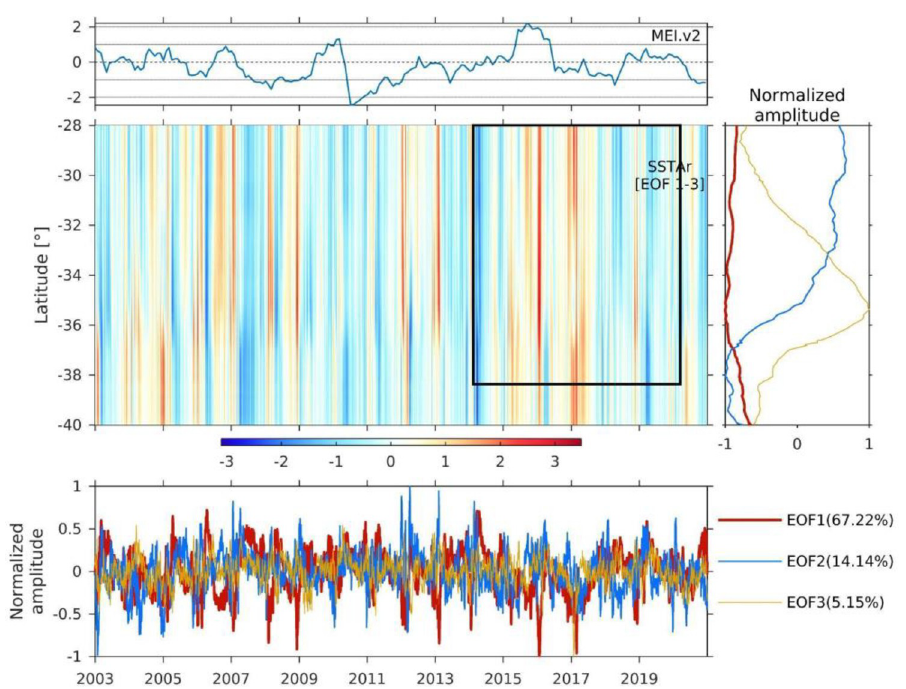
Fig 8. Time series of multivariate ENSO index version 2 (https://psl.noaa.gov/enso/mei/) (MEI, upper panel), and Hovmo¨ller diagram of the reconstructed sea surface temperature anomaly (SSTAr, medium panel) using the first three Empirical Orthogonal Function (EOF) modes. The spatial EOFs (right panel), the temporal EOF (bottom panel) and their variability contribution are also shown. The black box indicates the spatio-temporal scale of the crustacean demersal fishery